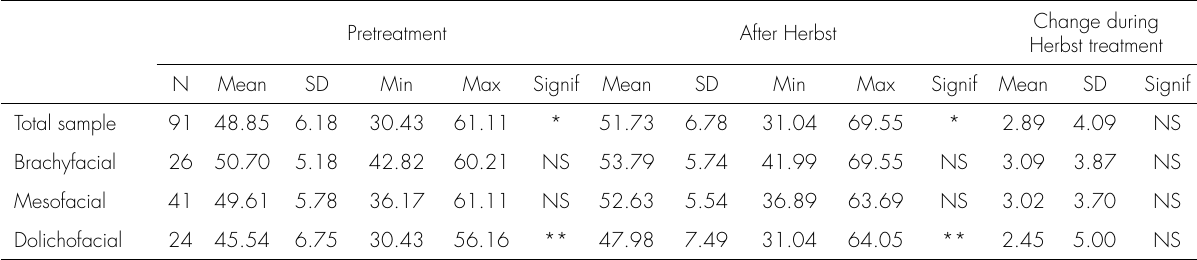
SD = Standard deviation, Min = minimum value, Max = maximum value, Signif = ANOVA, significant differences in means, NS = Not significant. * = p ≤ 0.05 ** = p ≤ 0.05, significant difference in vertical pattern